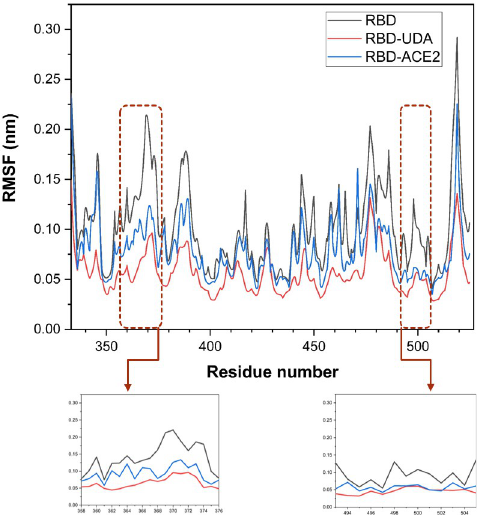
Fig 6. Comparison of C α atom RMSF of free RBD and RBD bonded UDA in 10 final nanoseconds of molecular dynamics simulation.